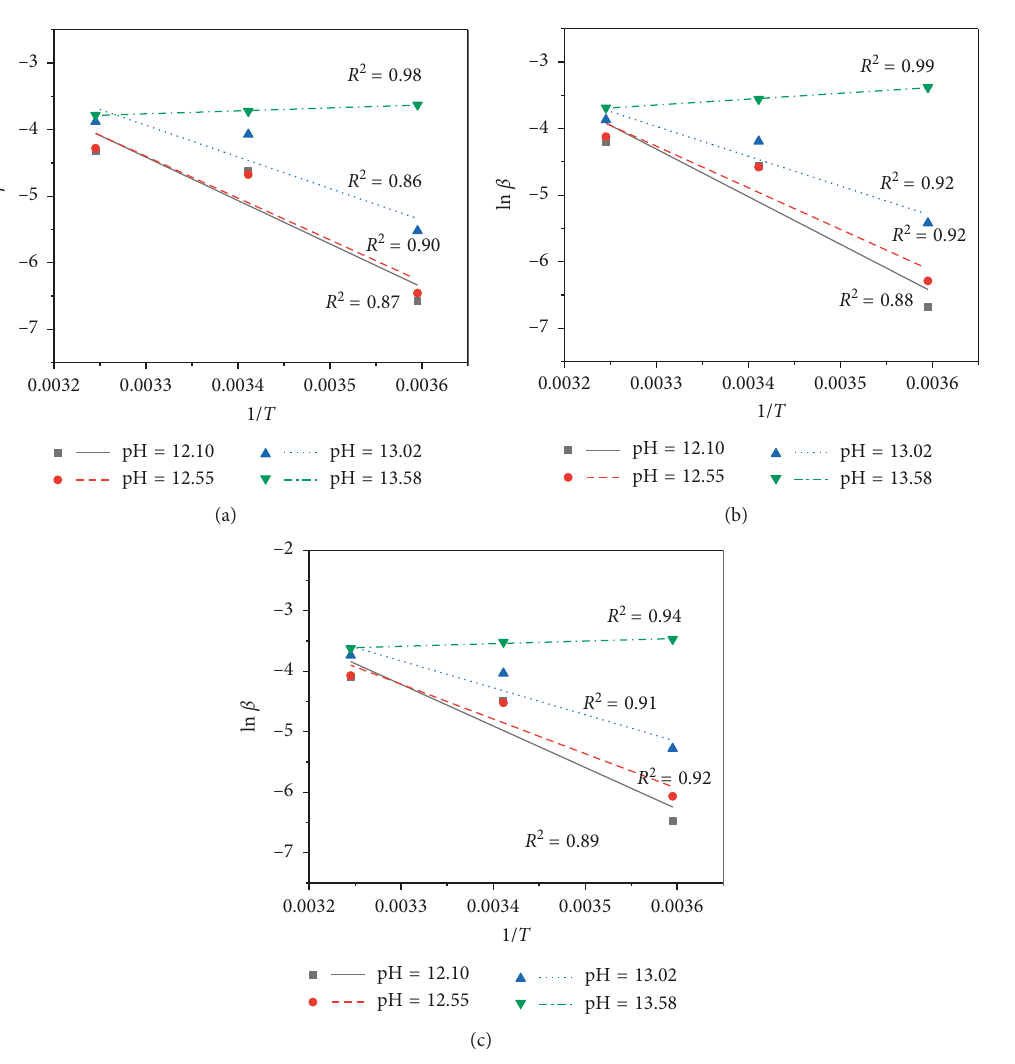
0.4; (b) w/s 0.5; (cid:31) (cid:31)